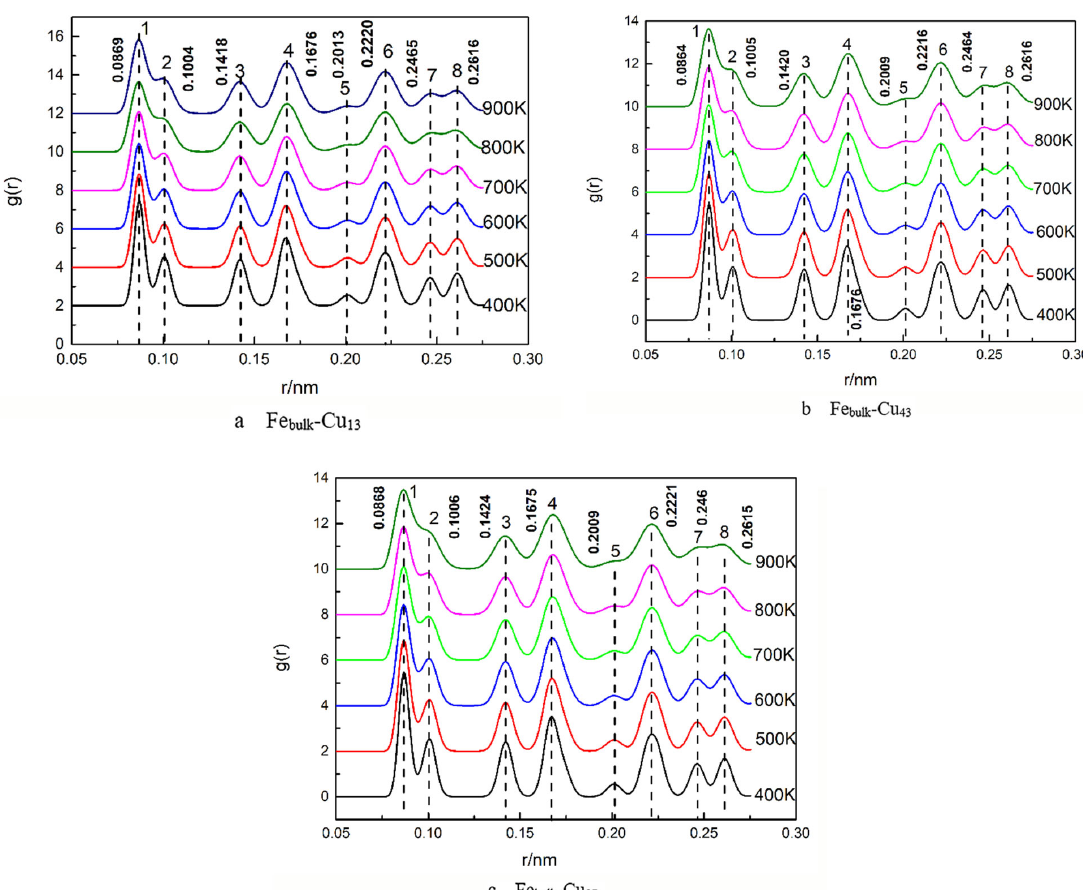
Figure 3. Pair distribution function curve of Cu atoms in Fe bulk –Cu n systems, n = 13 ( a ), 43 ( b ) and 87 ( c ). Figure 4 shows the atomic packing of these three Cu clusters at 400, 500, 600, 800 and 900 K along the (001) direction. For the Cu 13 cluster, as shown in Figure 4i, below 800 K, the thirteen atoms are at BCC lattice positions. Only at 900 K, one Cu atom leaves the lattice position. Because the radius of Cu atoms is only slightly larger than that of Fe at ‐ oms, when these Cu atoms are in the Fe bulk , they are strongly constrained by the surround ‐ ing Fe atoms, which greatly limits the mobility of the Cu atoms. In the case of the Cu 43 cluster, as shown in Figure 4ii, at 400 K these Cu atoms are at BCC lattice positions. As the temperature increases, a few Cu atoms adjust their positions. At 800 K, it can be seen that a certain number of atoms are not at lattice positions. Correspondingly, the peak shape of the PDF presents different features from those at low temperature, including lower peak height and increased width. For the Cu 87 cluster, as shown in Figure 4iii, at 400 K, when most of the Cu atoms are at BCC lattice positions, a small number of atoms present move ‐ ments contributing to the small increase in MSDs. At 600 K, all atoms are at lattice posi ‐ tions. As the temperature increases further, a few of atoms adjust their positions, resulting in the increases in the MSDs.